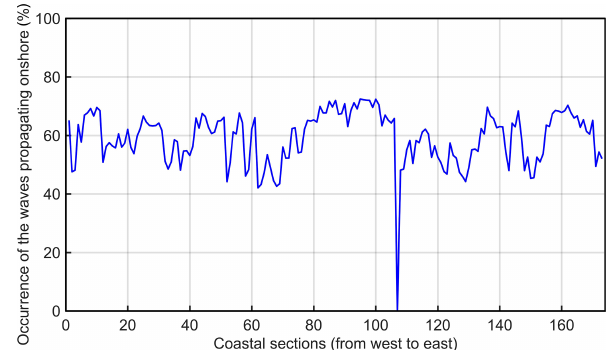
Figure 4. The percentage of occurrence of waves that propagate onshore and produce elevated wave set-up events in the study area.